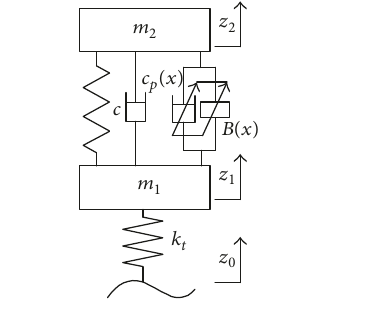
Figure 3: A semiactive inertance control